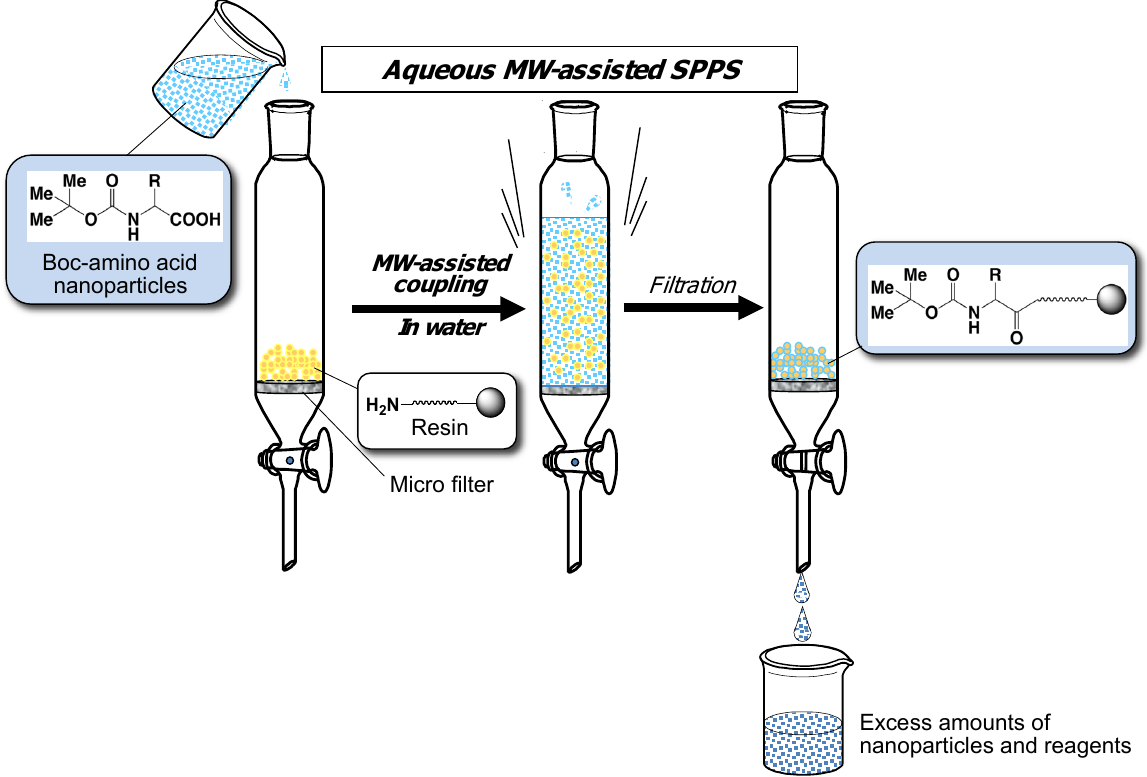
Figure 1. Aqueous microwave (MW)-assisted solid-phase synthesis using Boc-amino acid